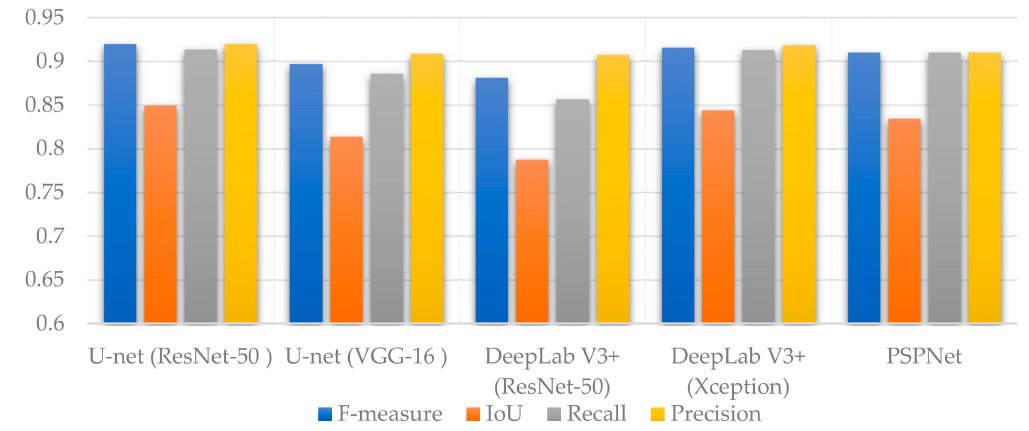
Figure 10. Summary of evaluation metrics of segmentation models obtained from the testing